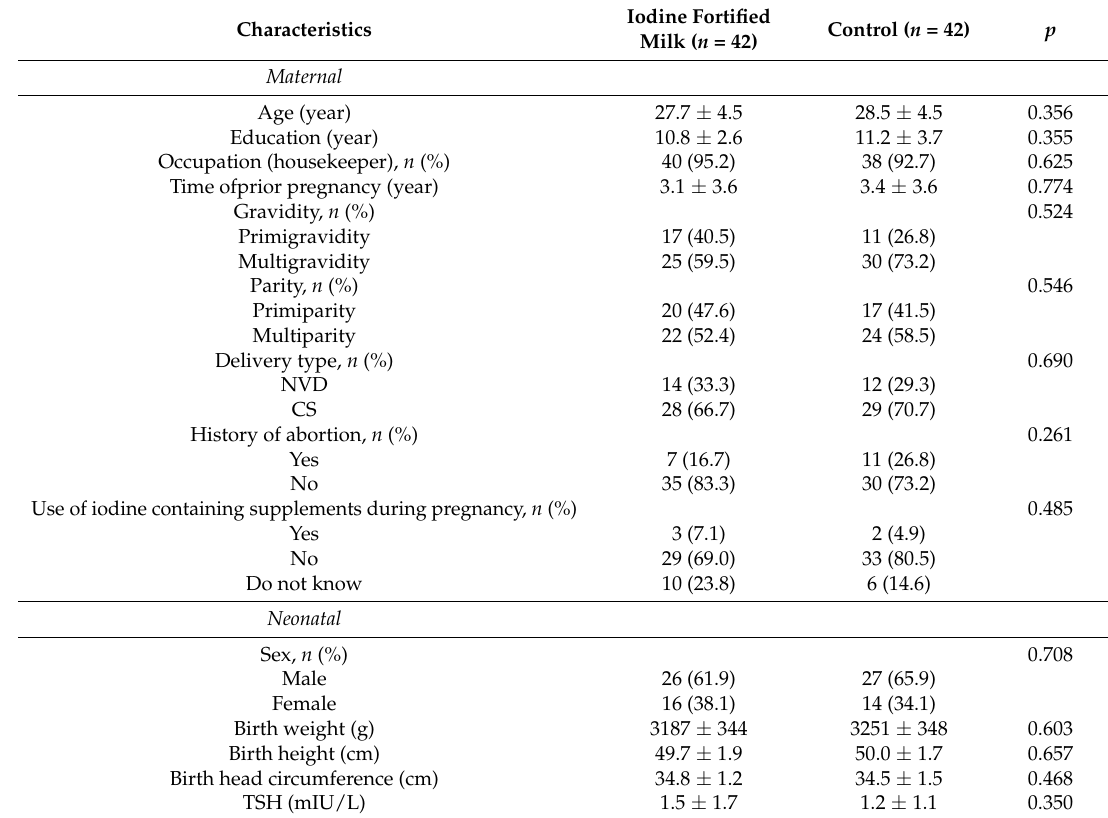
Table 1. Baseline characteristics of lactating mothers and their infants in the iodine fortified milk and control